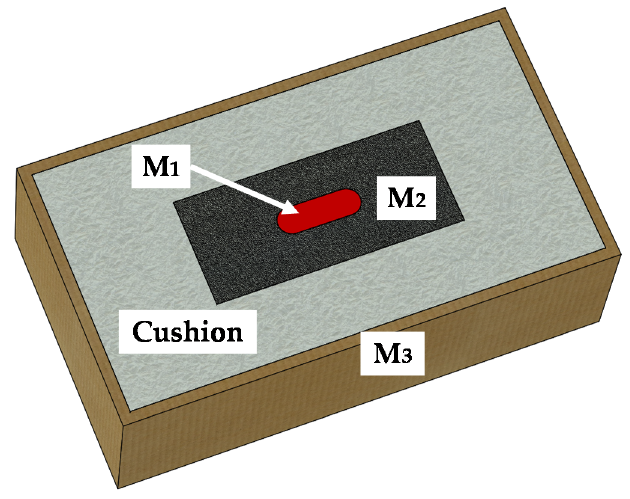
Figure 1. The conceptual structure of a packaging system using cushioning material.